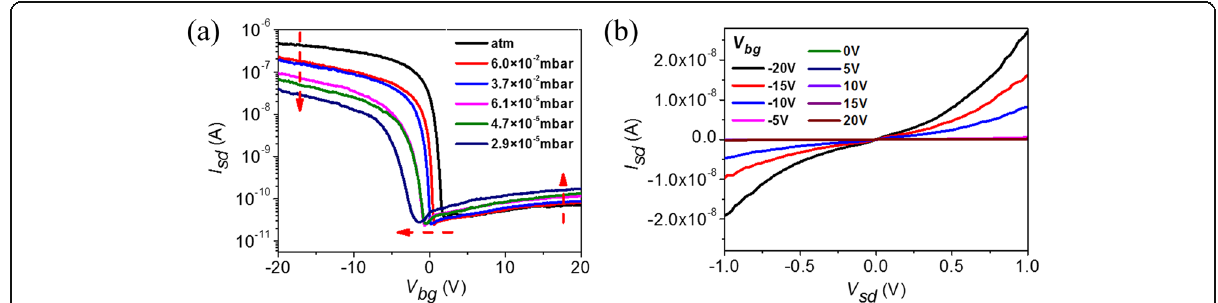
Fig. 3 P-type electric properties of multi-layered MoTe 2 transistor in vacuum. a RT transfer characteristics of a p-type MoTe 2 transistor at V sd = 1 V as a function of vacuum. b RT output characteristics of a p-type MoTe 2 transistor at different V bg in 2.9 × 10 − 5 mbar